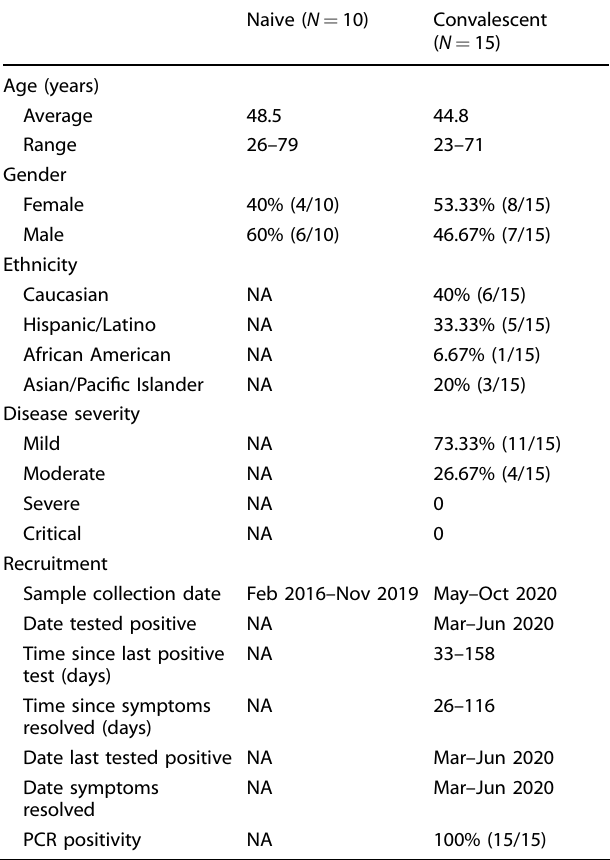
Table 3. COVID-19 convalescent and healthy donor cohort